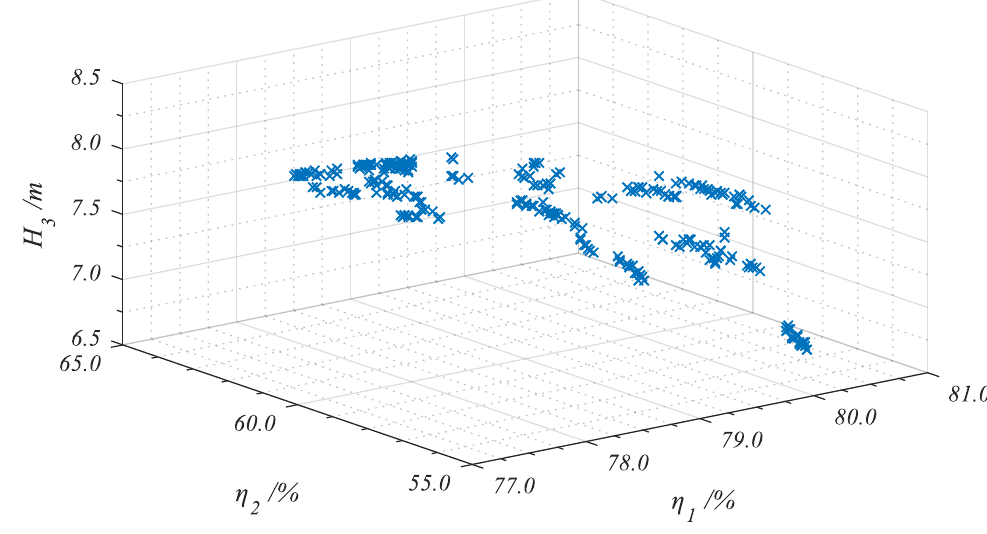
Figure 9. Pareto-optimal solutions in 3D function-space.